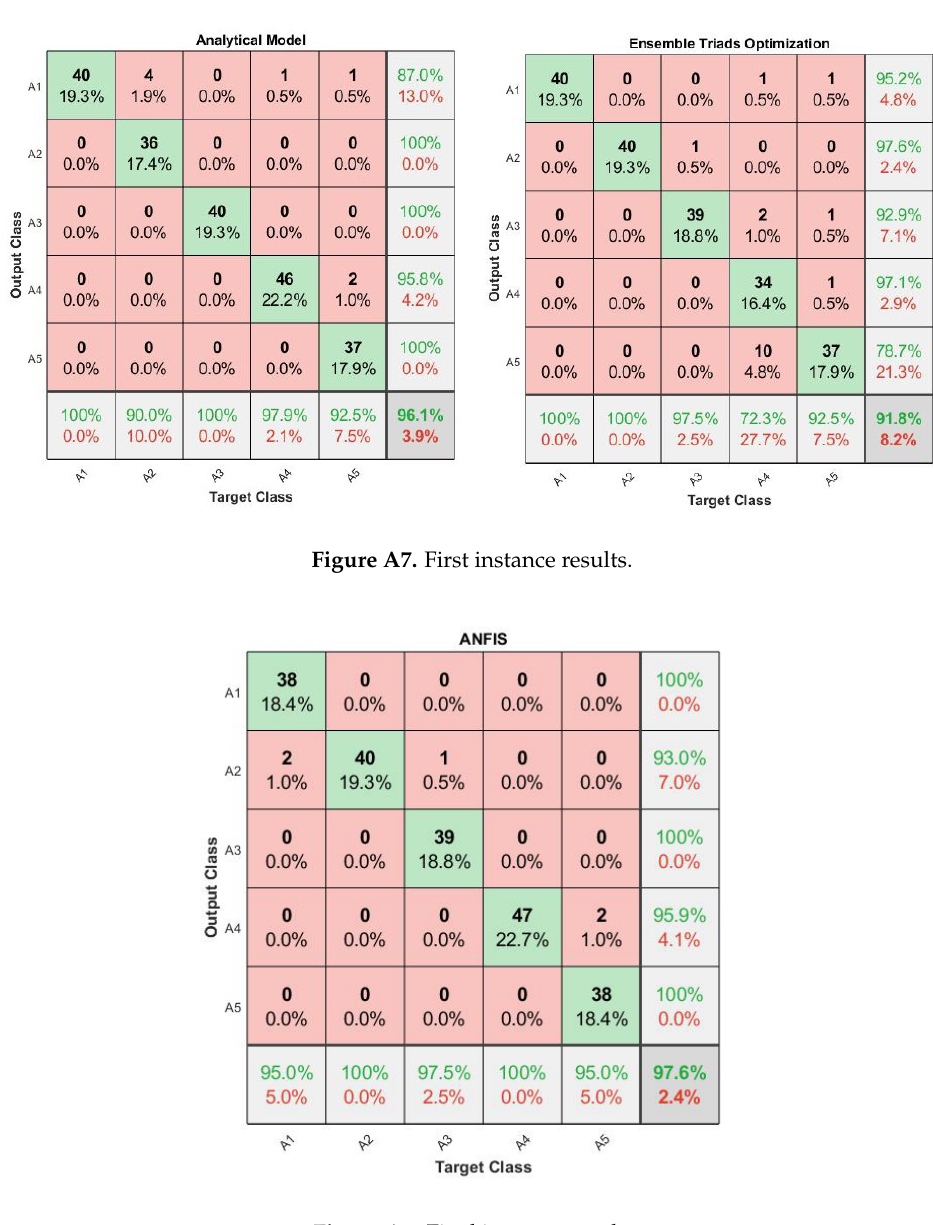
Figure A8. Final instance